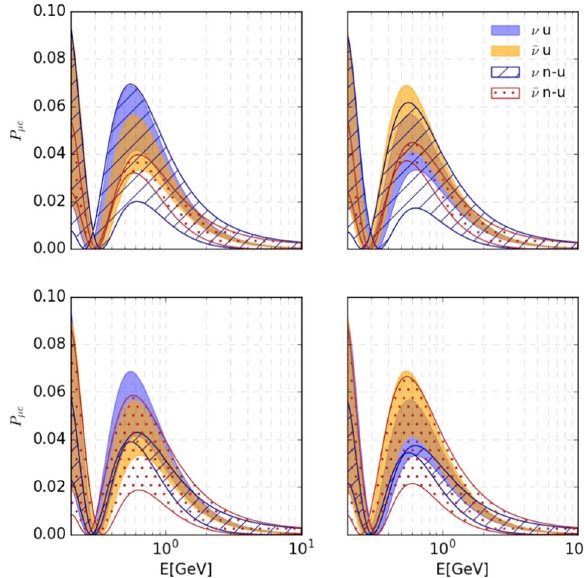
Fig. 4 Same as Fig. 3 but for the T2K experiment